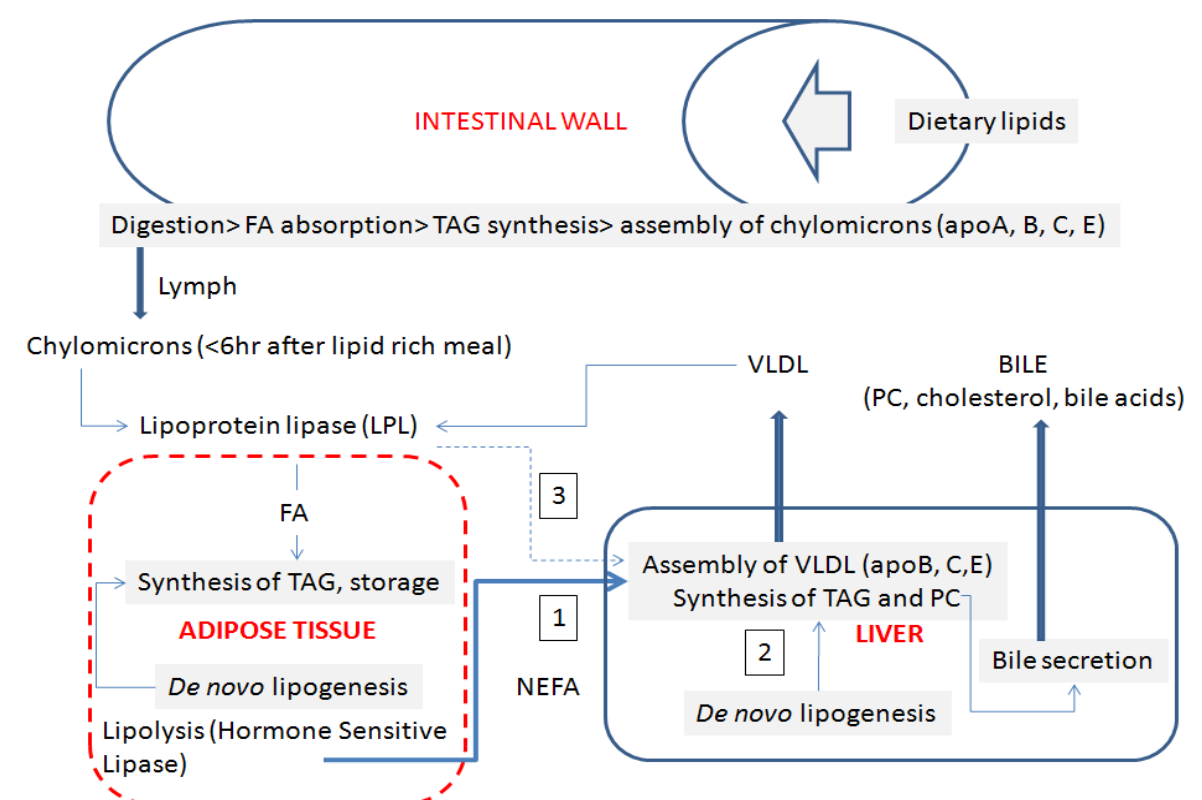
Figure 1. Pathways of lipid metabolism and traffic in